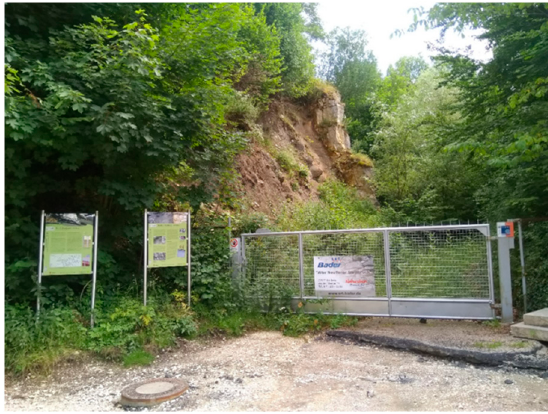
Figure 11. Geopoint Volcanic Vent Neuffen (Author 2020).